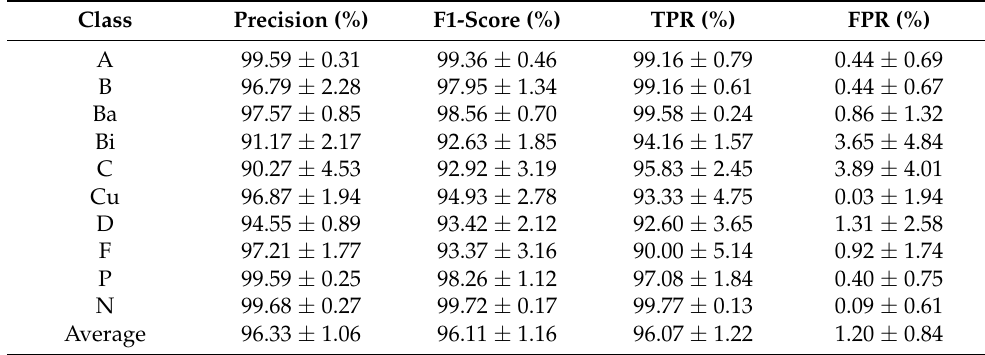
Table 6. Performance metrics of CNN 10-class configuration.